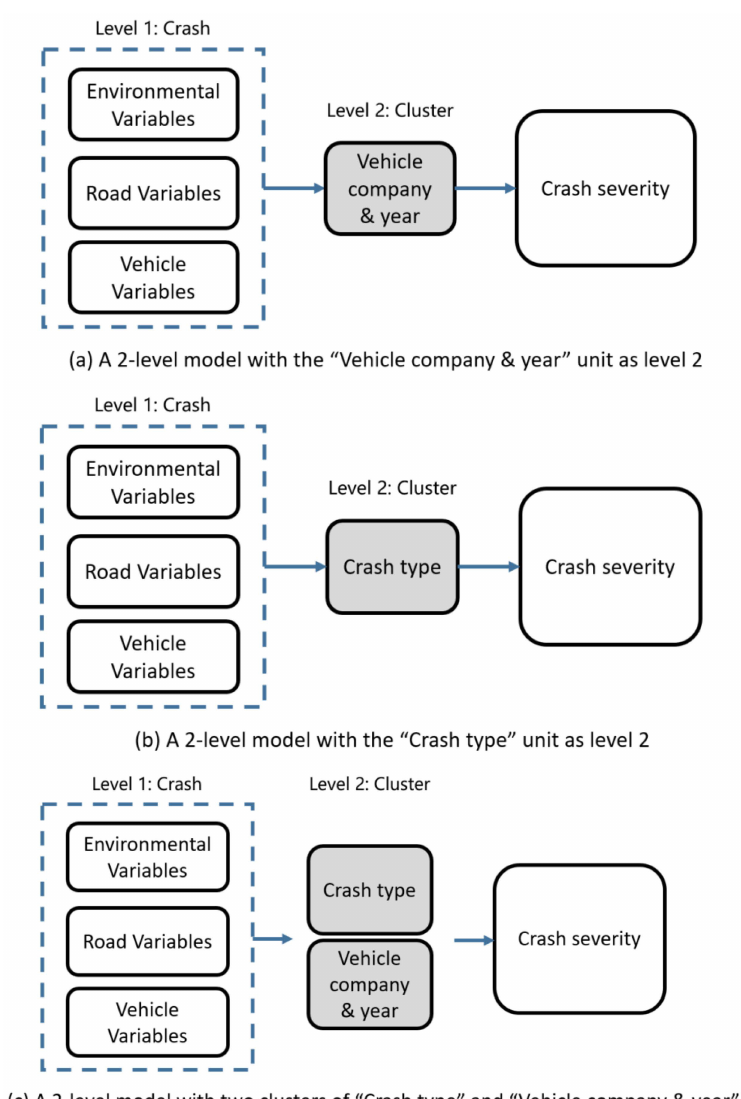
Figure 6. The structure of hierarchical Bayesian